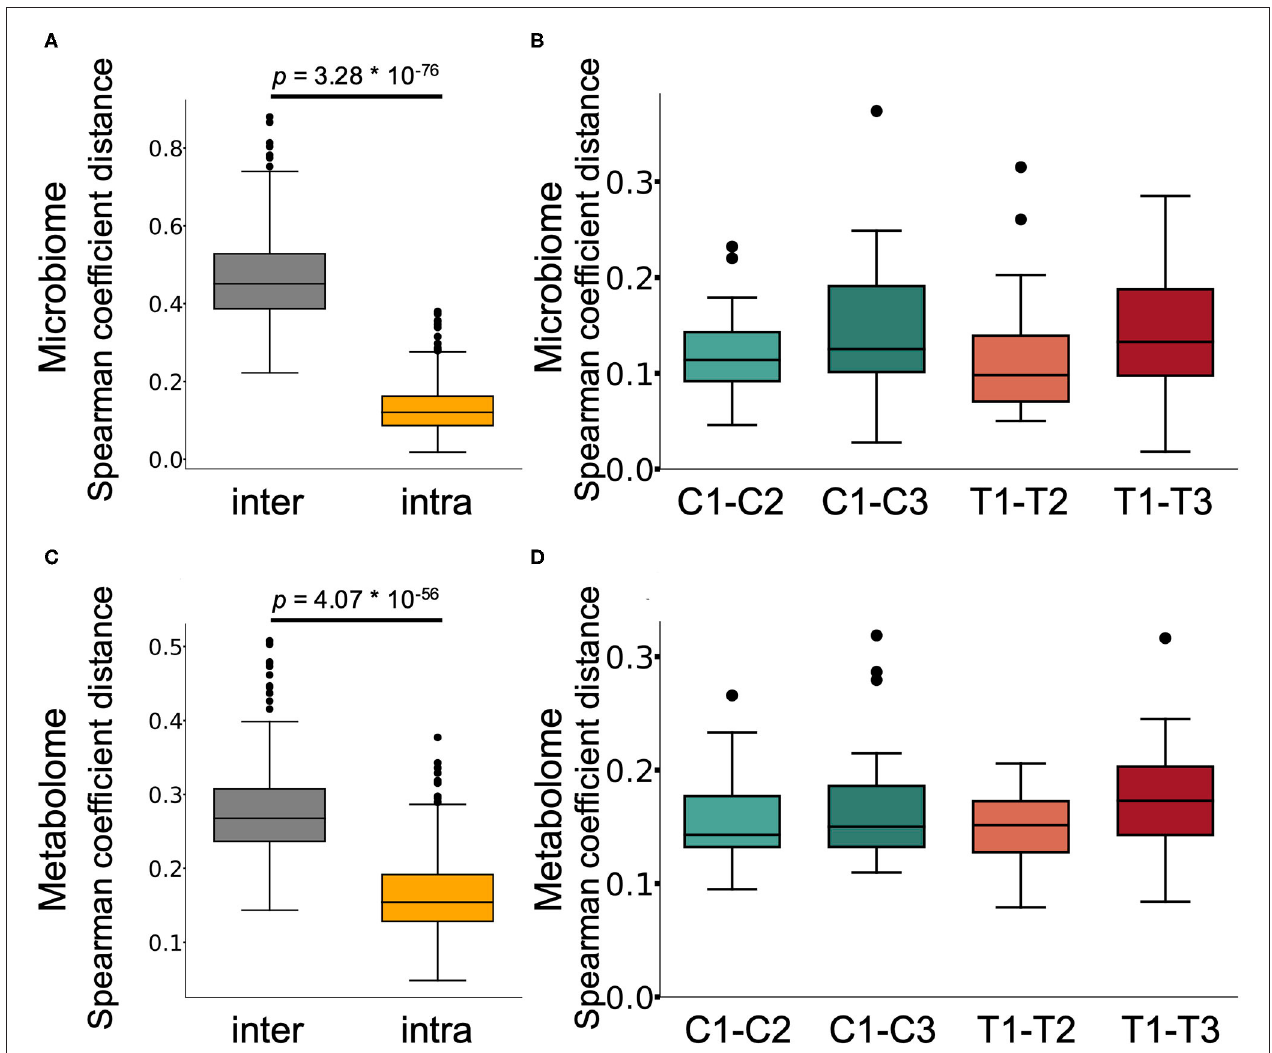
FIGURE 2 | The influence of Chlorella consumption on the gut microbiome and metabolome profiles was not larger than that of control supplement consumption. (A,C) Box plot representing the distribution of Spearman coefficient distance for the gut microbiome (A) and metabolome profiles (C) among samples from different subjects at the first timepoint (inter) and the distance between samples from the same subject (intra). (B,D) The boxplots show the microbiome profile distance (B) and metabolome profile distance (D) within an individual between the labelled timepoints. A significant difference test was performed during the same intake period (T1–T2 and C1–C2, or T1–T3 and C1–C3), but no significant difference was detected (Wilcoxon signed-rank